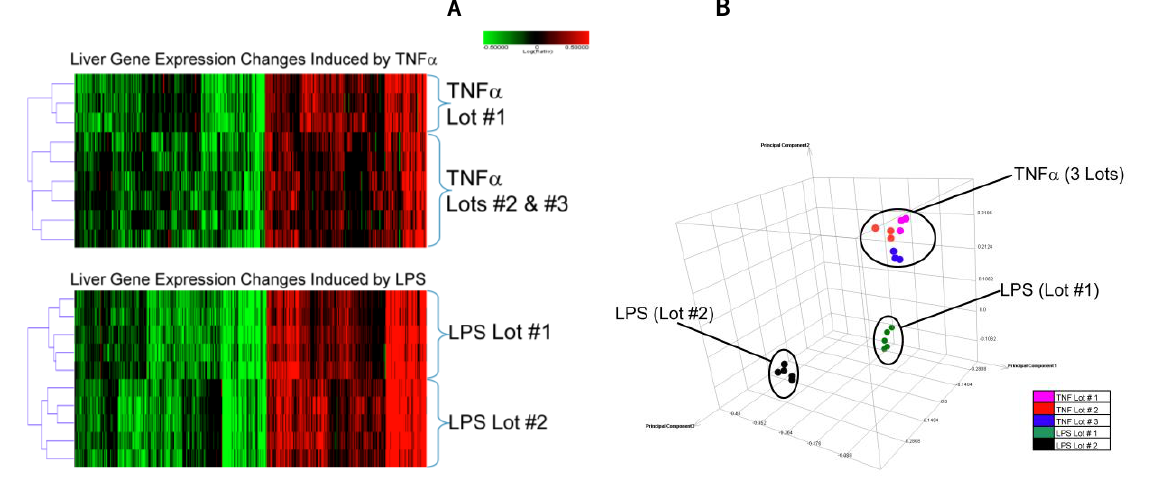
Figure 1. ( A ) Comparison of the hepatic gene expression profiles for LPS- or TNFα-treated rats using separate lots of each agent. Individual probe sets (genes) are displayed on the horizontal axis and each individual treatment is on the vertical axis. Shades of red indicate increased expression relative to the vehicle (Veh) treatment, and shades of green indicate decreased expression. Black indicates no statistically significant change in expression. Both the genes and experiments were analyzed using divisive hierarchical cluster analysis with Euclidean distance as the similarity measure. The dendogram shows relative similarities between the individual expression profiles. Statistical filters were applied using |fold change| ≥ 2.0 and p  0.01 in at least one rat. Number of probe sets represented in each heatmap is TNFα (~2700) and LPS (~5600). Lot designations: TNF Lot #1 (098K1865); TNF Lot #2 (126K1053); TNF Lot #3 (087K1290); LPS Lot #1 (51K4115); LPS Lot #2 (024K4067). ( B ) Principal component analysis (PCA) of liver gene expression profiles for all TNFα-treated and LPS-treated rats. Three principal components were generated and plotted for each expression profile (|fold change| ≥ 2.0 and p  0.01) using Rosetta Resolver software. Treatments that clustered together are represented within the same